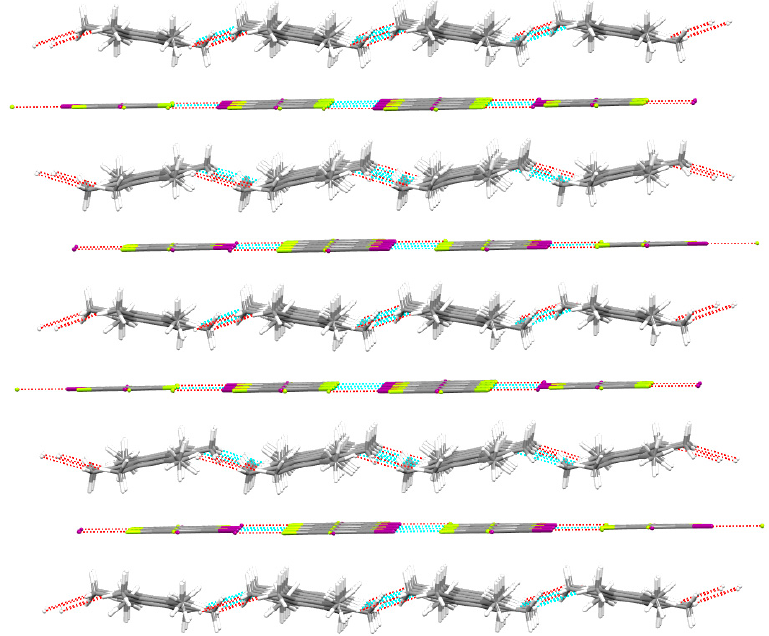
Figure 3. The side view of the sandwiched-layer structure of the cocrystal.